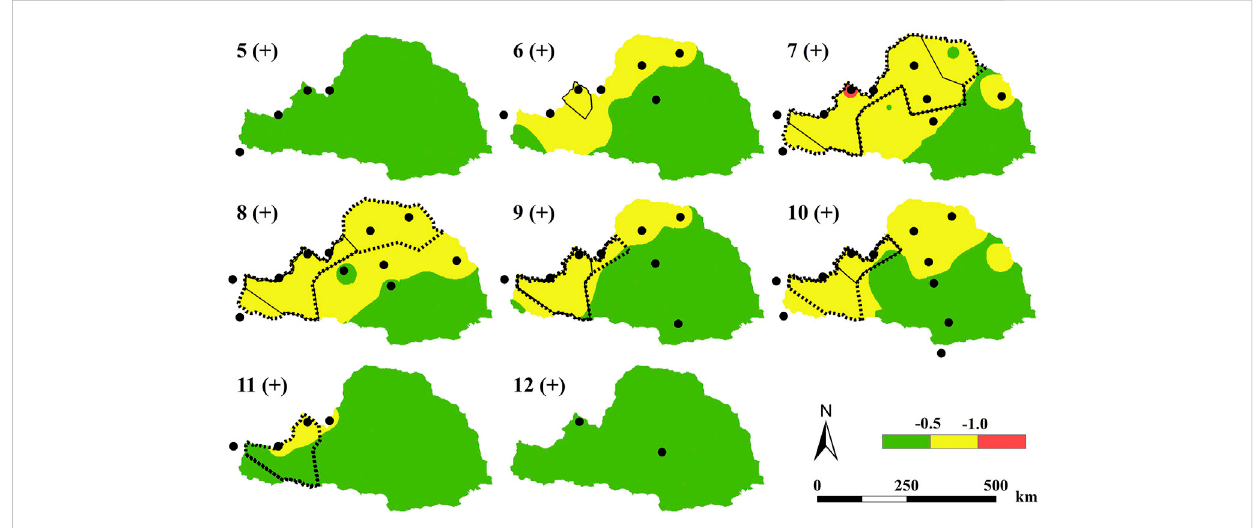
FIGURE 13 Spatial distribution of SPI6 averages for different months from May to December for the year after La Niña (pluses). Same as Figure